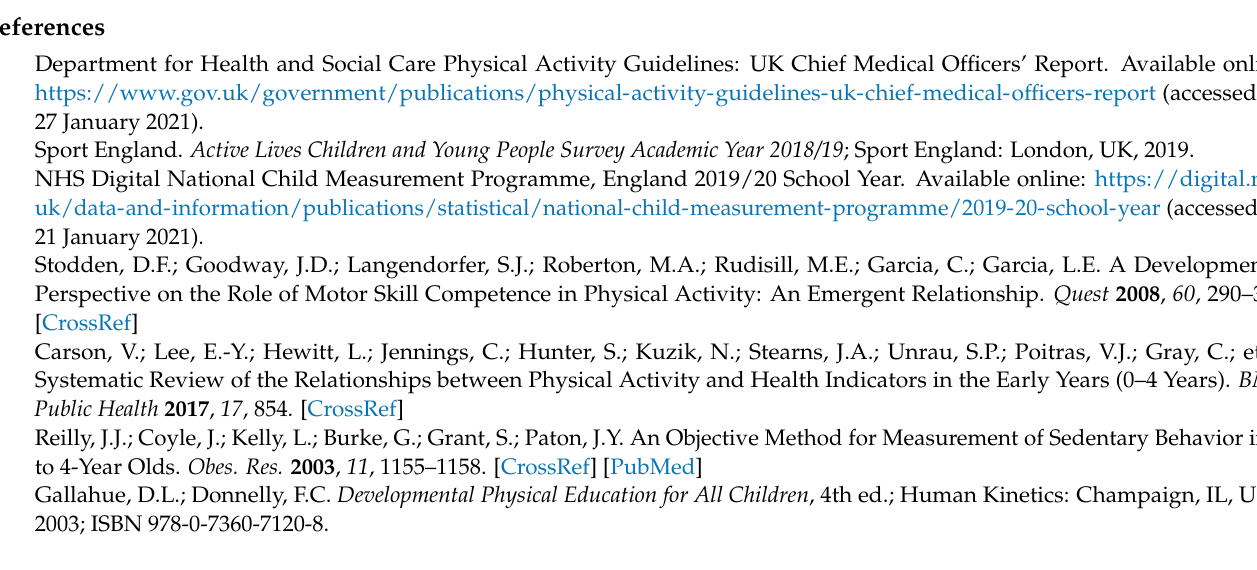
Figure A1. Theme